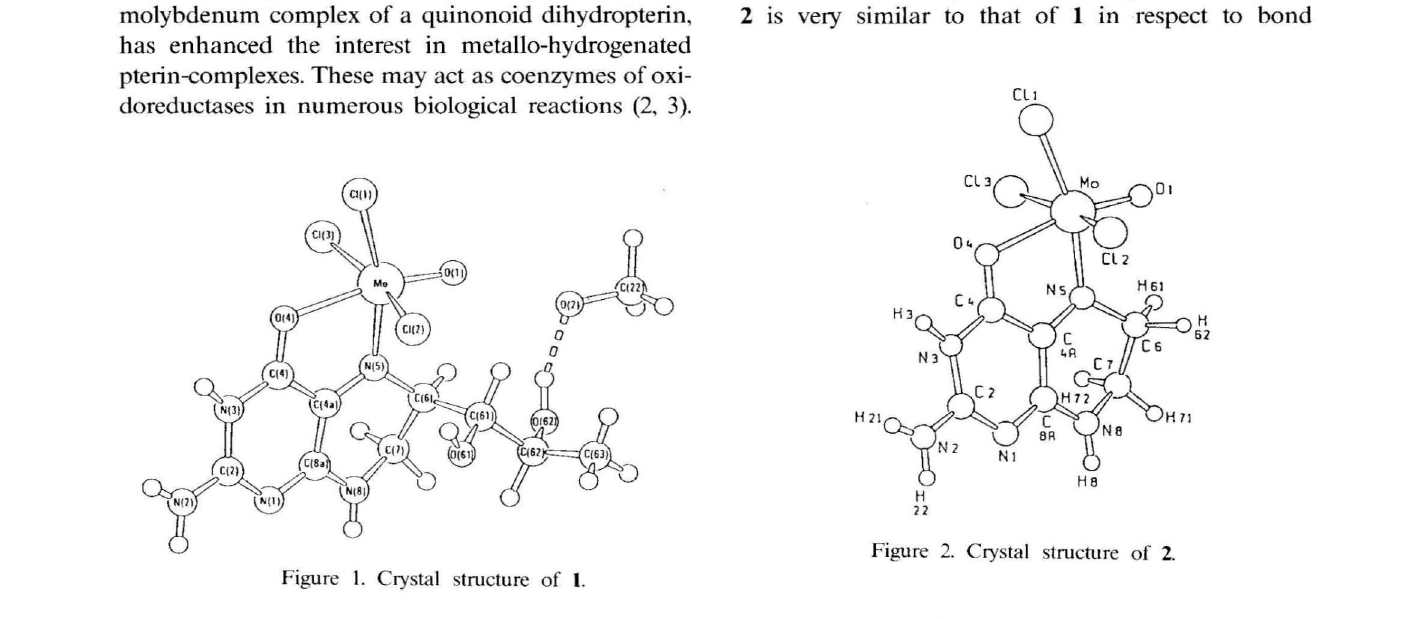
Figure I. Crystal structure of I.